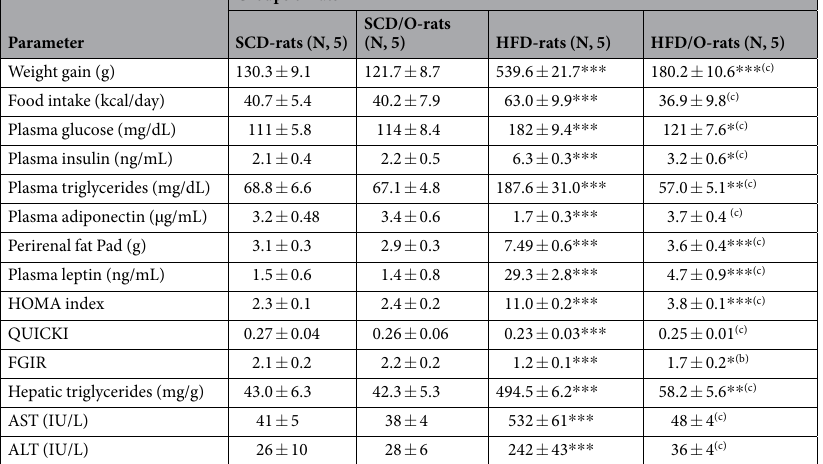
3 Scientific REPORtS | (2018) 8:1540 | DOI:10.1038/s41598-018-19973-z